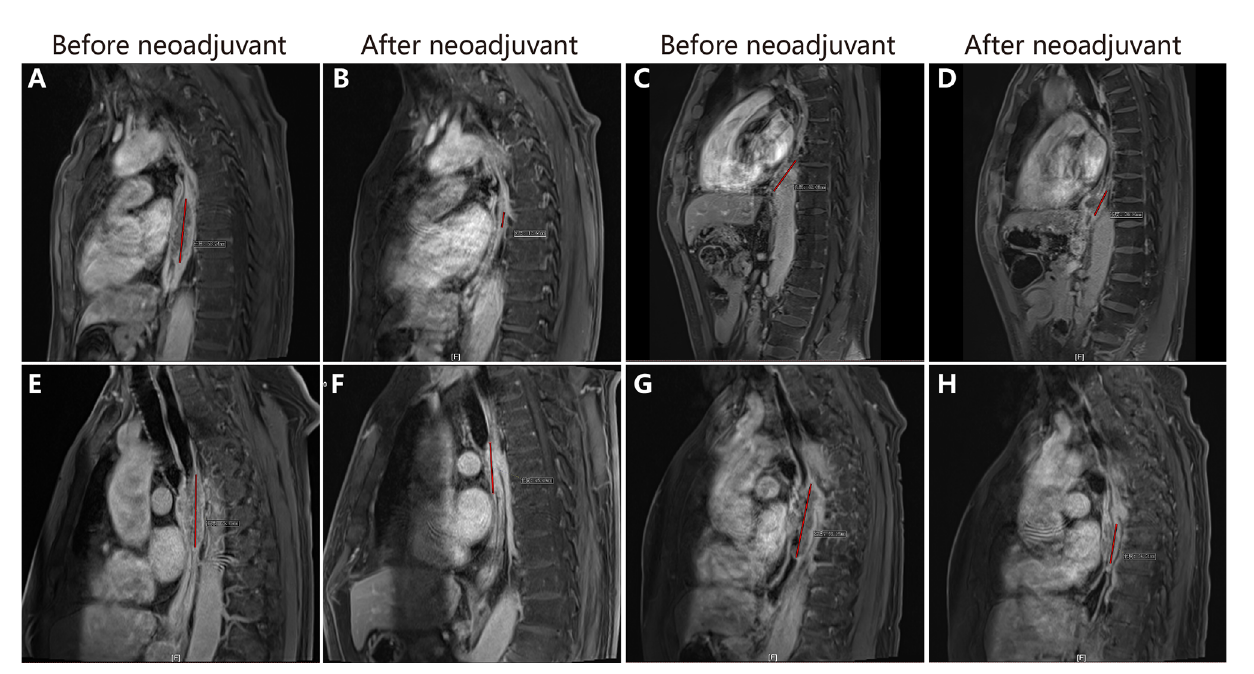
FIGURE 2 | The changes of esophageal lesions in magnetic resonance imaging. (A, B) show the esophageal lesion in patient 4 before and after neoadjuvant chemoimmunotherapy, the lesion reduced signi fi cantly. (C, D) show esophageal lesion in patient 7 before and after neoadjuvant chemoimmunotherapy. (E, F) show esophageal lesion in patient 1 before and after neoadjuvant chemoimmunotherapy. (G, H) show esophageal lesion in patient 8 before and after neoadjuvant